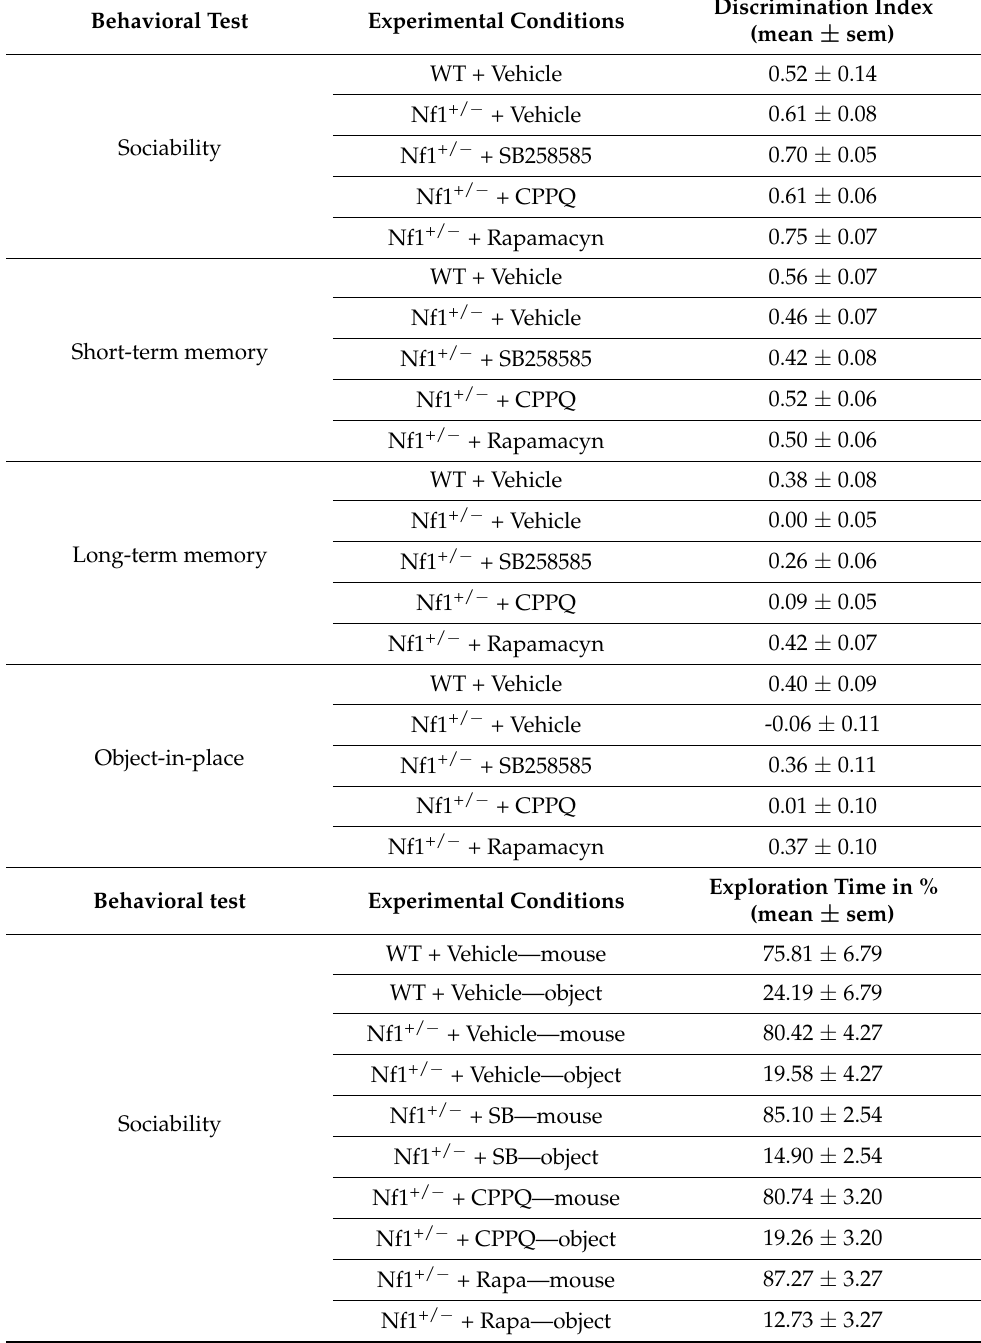
Table 1. Discrimination Indexes and exploration time (in percent) obtained for each behavioral test